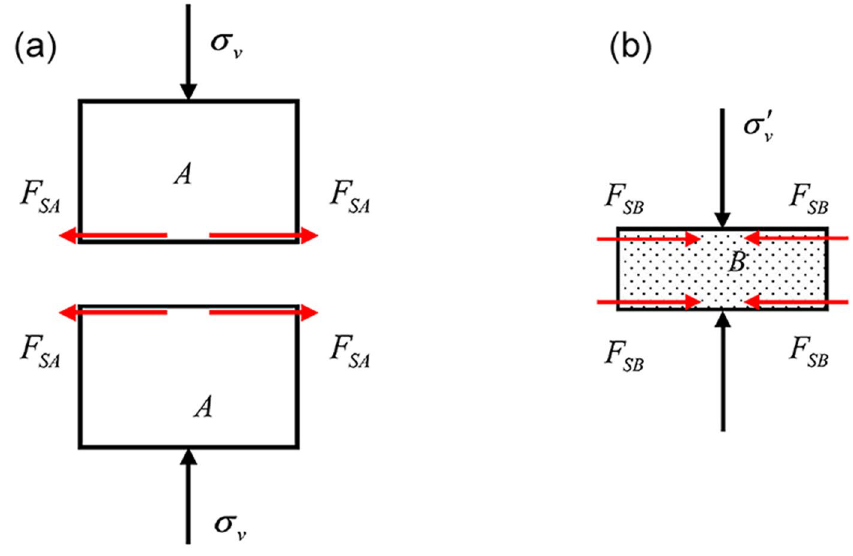
Figure 5. Derived friction binding force distribution of ( a ) the main rock mass and ( b ) the interlayer under uniaxial compression.